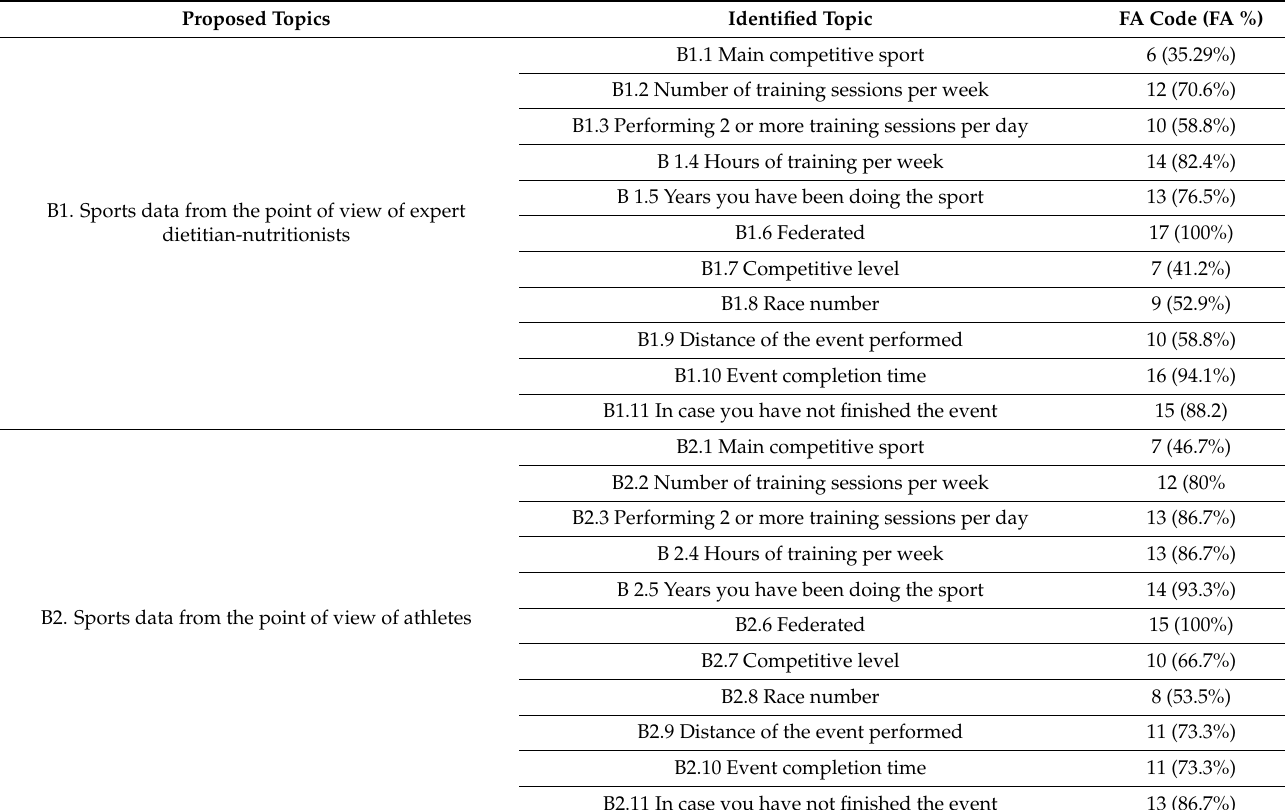
Table 2. Results of the focus groups for the content of part II of the questionnaire, related to sports data.